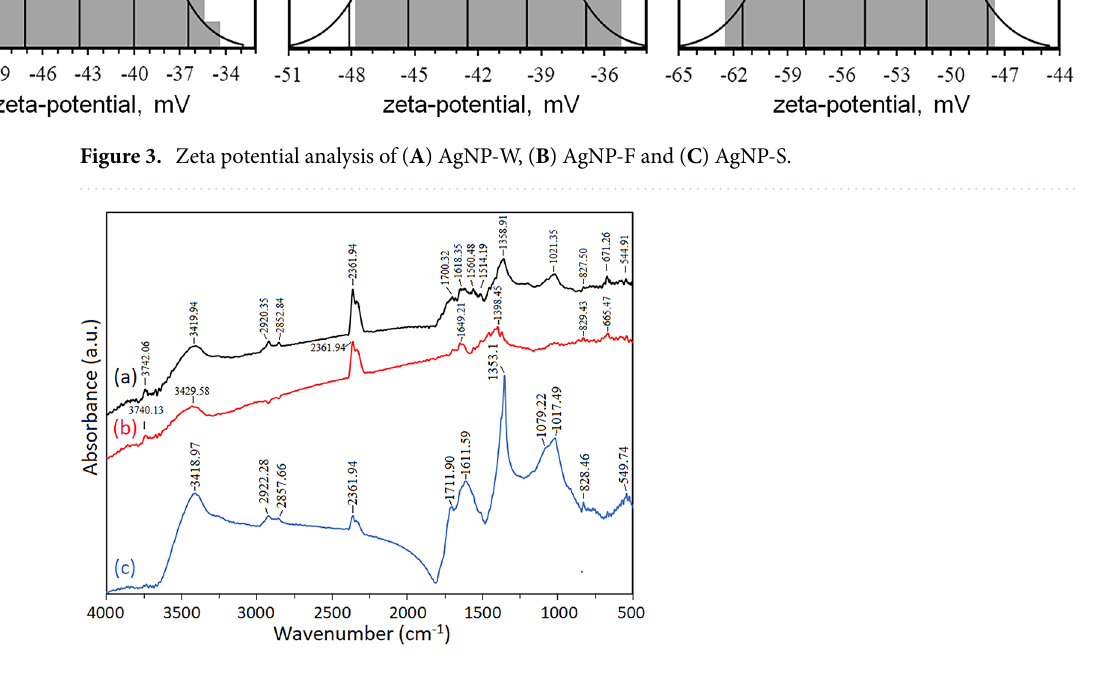
Figure 4. Fourier transform infrared spectra of ( a ) AgNP-W, ( b ) AgNP-S, and (c)